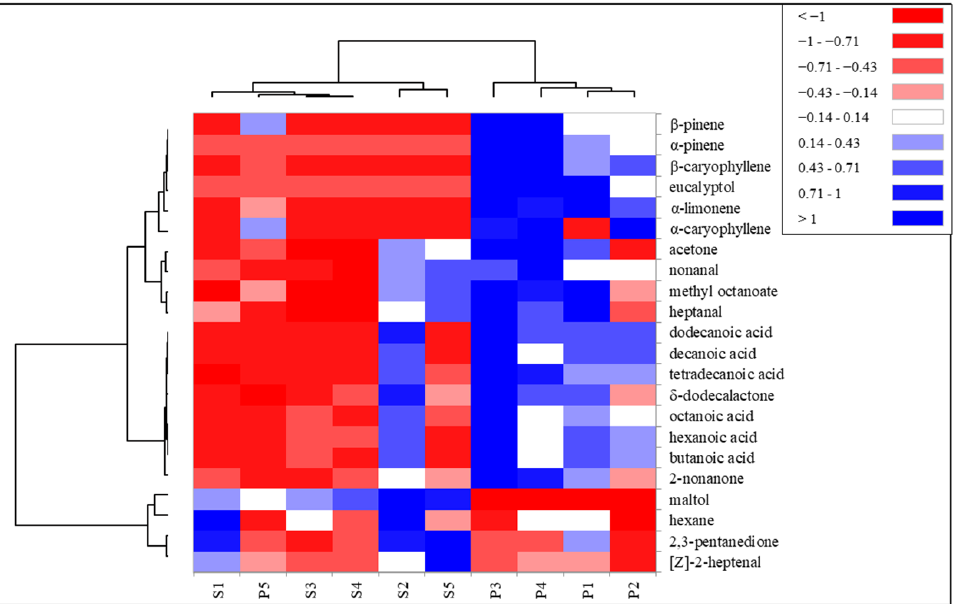
Figure 3. Heat map of the diversity of volatile compounds in Pasture (P) and Stall (S) milk samples of the five milking periods. Volatile compounds were plotted on the Y axis, while the X axis had the milk samples from each period. Results are displayed as negative ( − 1) to positive (+1) correlation of the volatile compounds in the permuted matrix for the respective milk samples. The cluster lines on the left side of Figure 3 represent volatile compounds clusters.